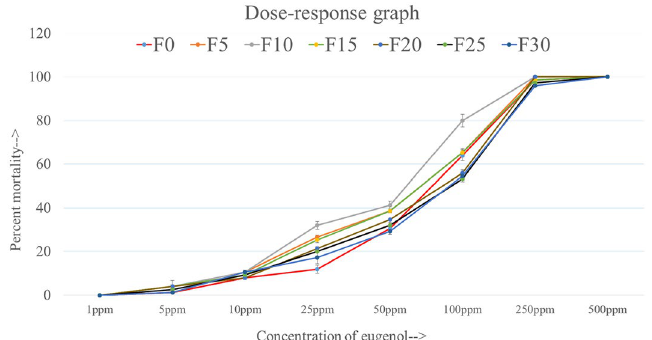
Figure 1. Response of 4th instar larvae to a graded concentrations of eugenol over a generational time (± SE).